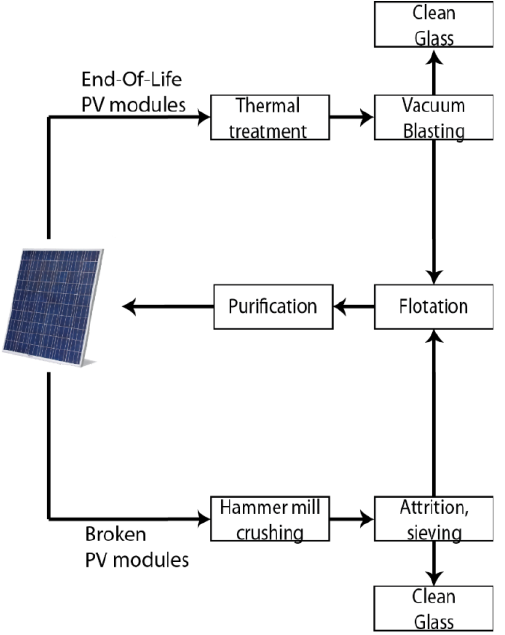
Figure 5. Two CdTe/CIGS thin-film PV module recycling strategies flow chart: intact, at the end of its life cycle and in case the glass plate is broken .